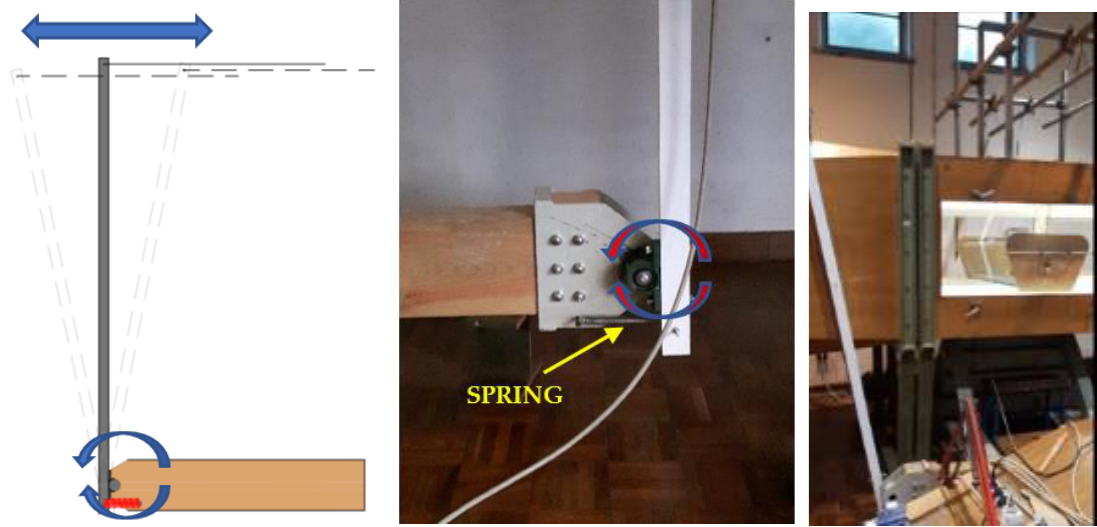
Figure 9. System for frequency reduction and model suspension.